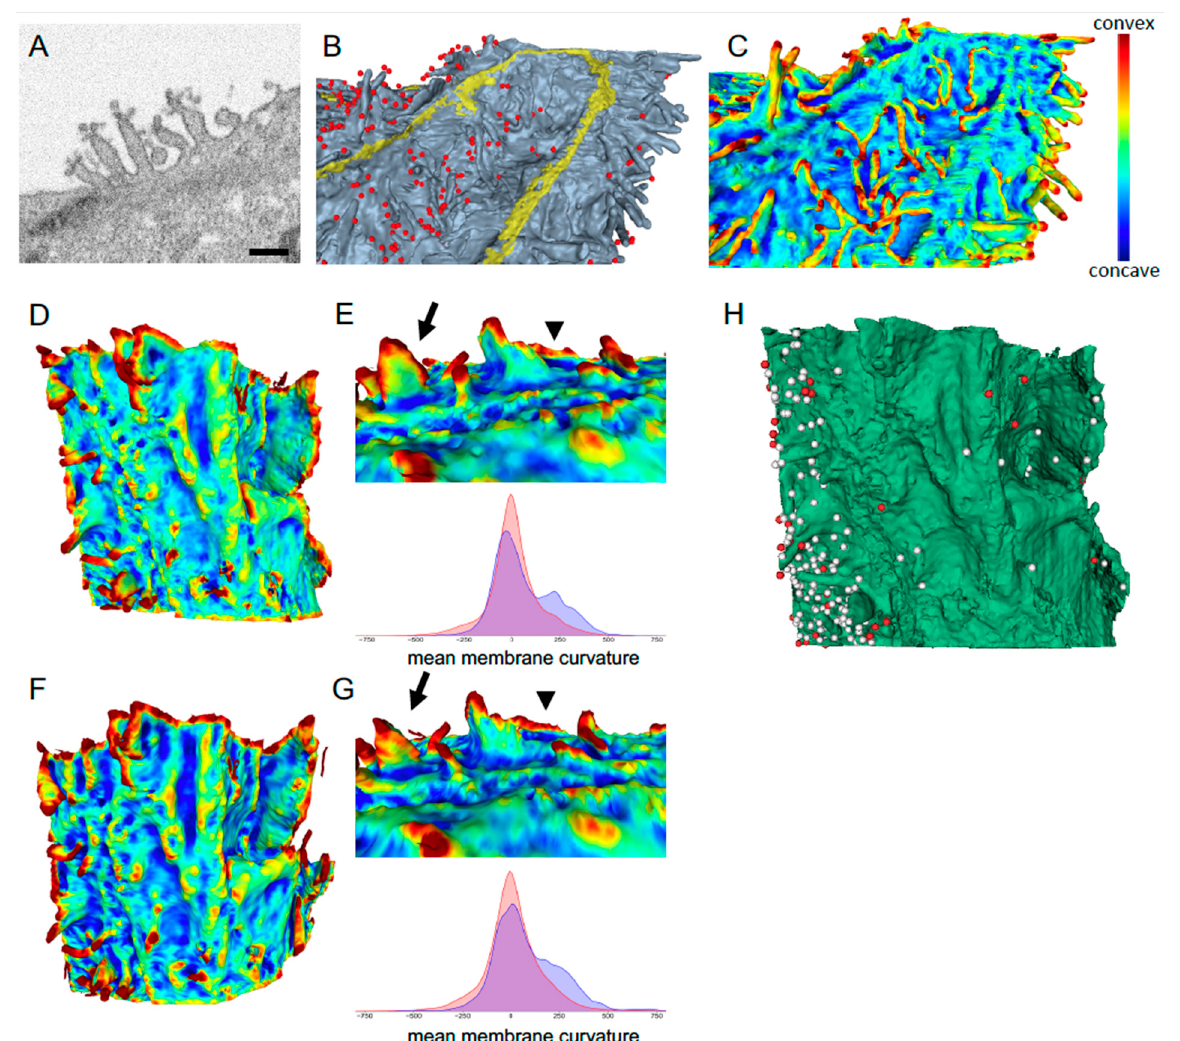
Figure 3. Quantitation of membrane curvatures and viral densities from FIB-SEM . ( A ) FIB-SEM micrograph showing viral particles preferentially associated with filopodia. Scale bar, 500 nm. ( B ) 3-D reconstruction of a SARS-CoV-2 infected Vero E6 cell. Gray, plasma membrane; yellow, tight junction; red, virus. ( C ) Heat map of the surface mean curvature of the cell in B. ( D ) Heat map of the surface mean curvature of the membrane depicted in Figure 2B,C (green cell) at 8 × 8 × 8 nm pixel sampling. ( E ) Top, heatmaps of representative sub-area, compare with ( G ). Bottom, correlation between a cell’s mean membrane curvature and the presence of virus particles from the FIB-SEM volume shown in ( D ). Blue, virus particles near the cell membrane (<100 nm distance). Red, randomly sampled points along the cell membrane. ( F ) Simulated SBF-SEM of the same surface in D, but now at 8 × 8 × 48 nm resolution. The sparser z sampling is reflected in horizontal ridges in the reconstruction. ( G ) Top, Heatmap corresponding to area in E. Arrow, warped features; arrowhead, sawtooth or ridge artifact in SBF-SEM but missing in FIB-SEM ( E ). Bottom, correlation between mean membrane curvature and presence of virus particles in ( F , H ). Same surface as ( D ) showing viral particles, white fiducials. Red fiducials, viral particles missed in the lower z resolution simulated SBF-SEM